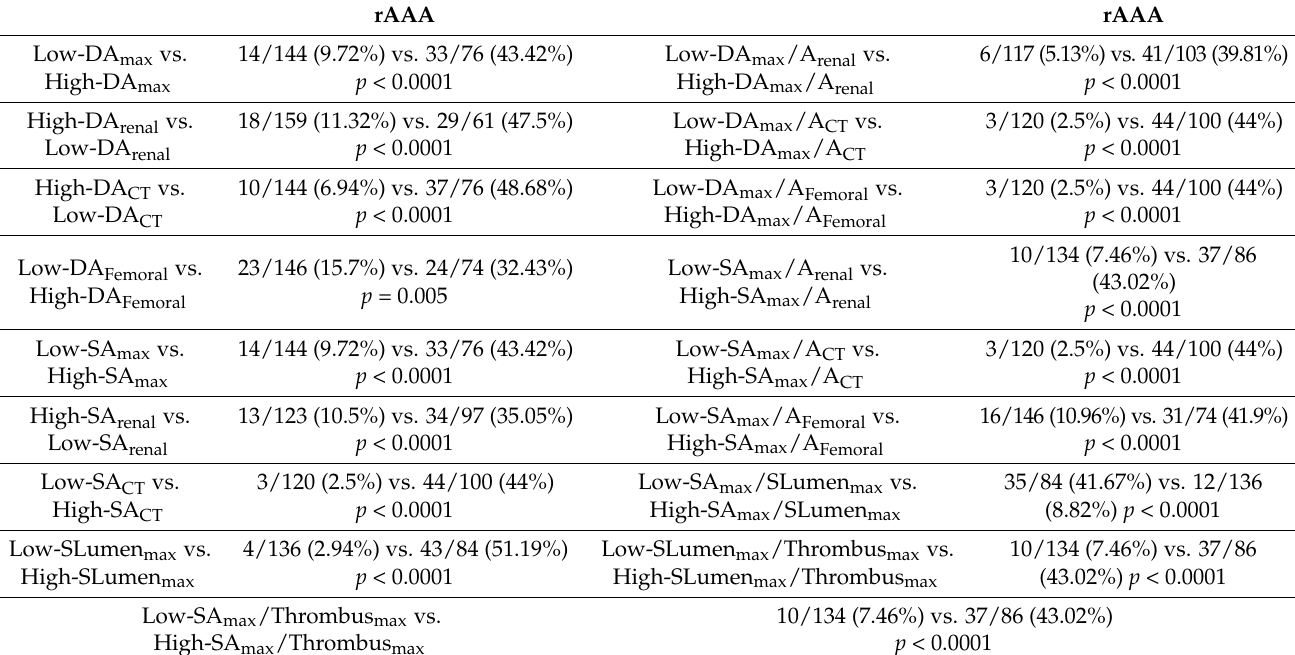
Table 4. Univariate analysis of imaging markers and risk of AAA rupture.